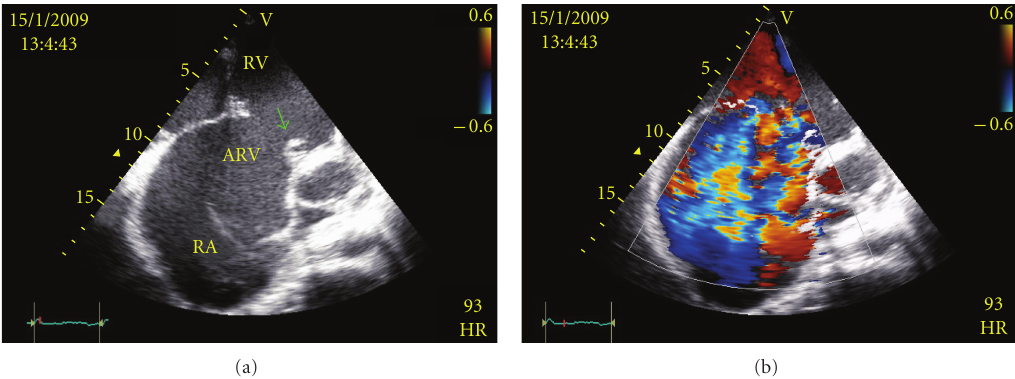
Figure 1: Transthoracic apical four-chamber view showing: (a) downward displacement of the septal leaflet of the tricuspid valve (arrow) in relation to the anterior mitral valve leaflet (MV), several enlargement of right atrium (RA), atrialized portion of right ventricle (ARV), and true right ventricle (RV); (b) severe tricuspid valve regurgitation due to the anomalous valvular arrangement.